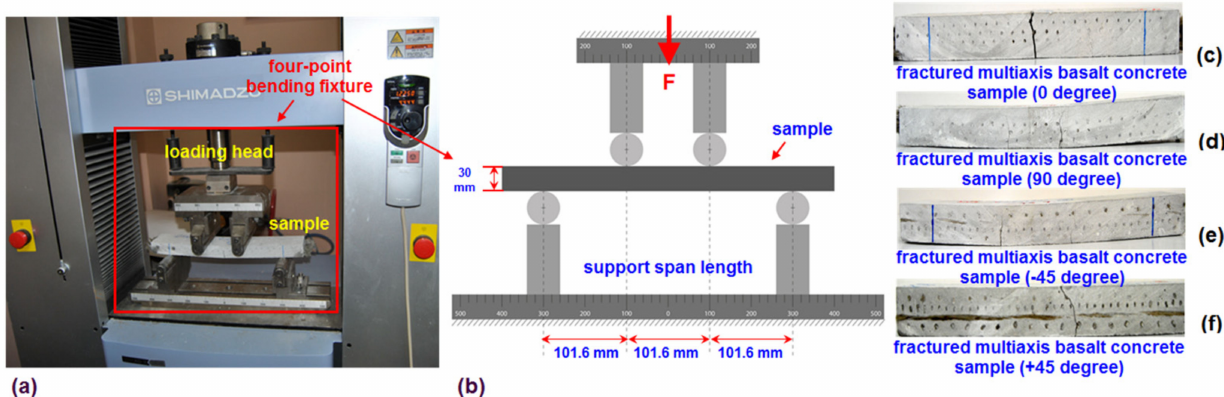
Figure 3. Flexural test of the multiaxis 3D basalt concretes. ( a ) Multiaxis 3D basalt fiber concrete sample in the universal testing instrument; ( b ) specimens with a four-point flexural test fixture, schematic; ( c ) failed basalt concretes, B-4D-(0 ◦ ); ( d ) B-4D-(90 ◦ ); ( e ) B-4D-(+45 ◦ ) and ( f ) B-4D-( − 45 ◦ ), (digital